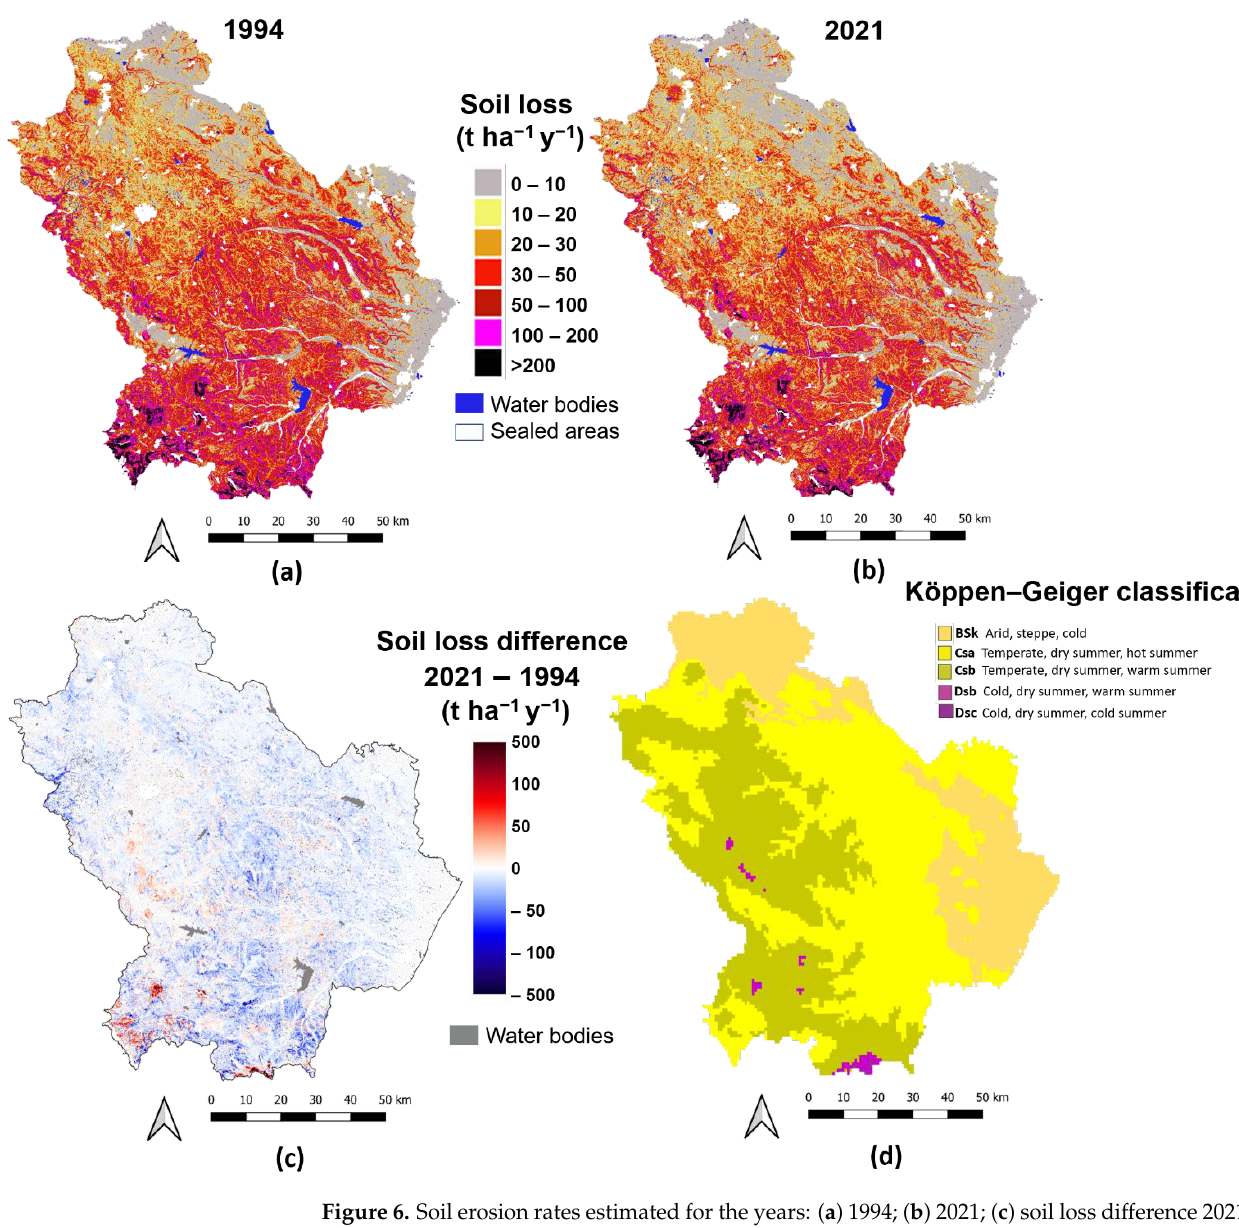
Figure 6. Soil erosion rates estimated for the years: ( a ) 1994; ( b ) 2021; ( c ) soil loss difference 2021–1994; ( d ) Köppen–Geiger classification of climates.